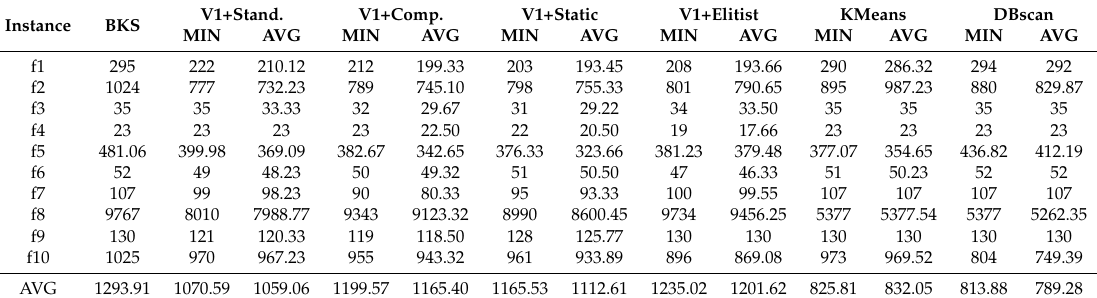
Table A16. CSA/KP—VShape 1—Two-steps vs. KMeans vs. DBscan.